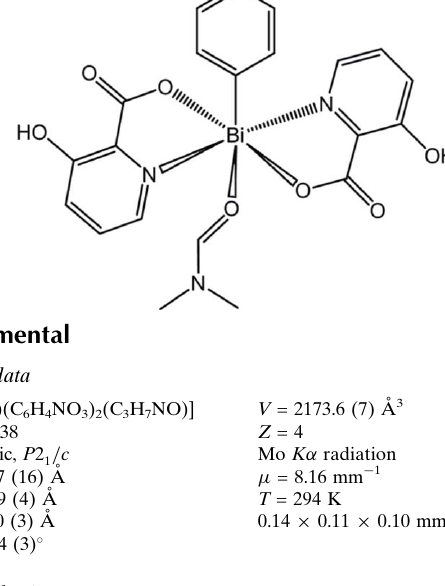
H NO)], features a Bi III atom in a distorted pentagonal- (C 3 7 pyramidal coordination by two N , O -donating bidentate 3- hydroxypicolinate (3-hpic) ligands, one monodentate dimethylformamide (dmf) molecule and one phenyl ring.